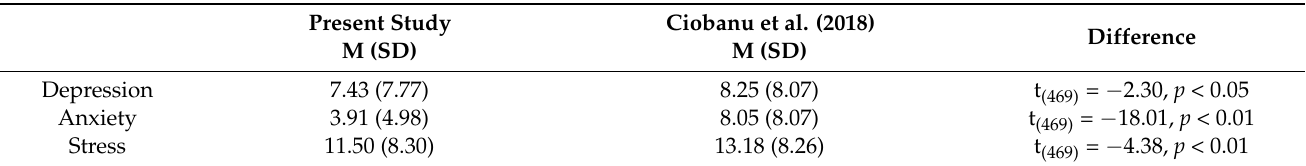
Table 1. Descriptives and comparisons between the subscales of negative affectivity of the present study and the validation sample [49].